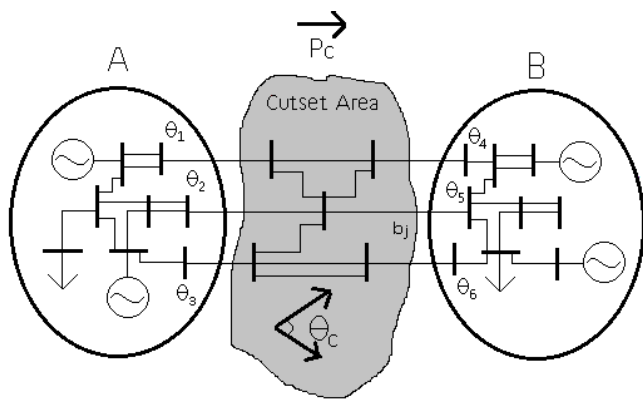
Figure 2. Cutset angle between two